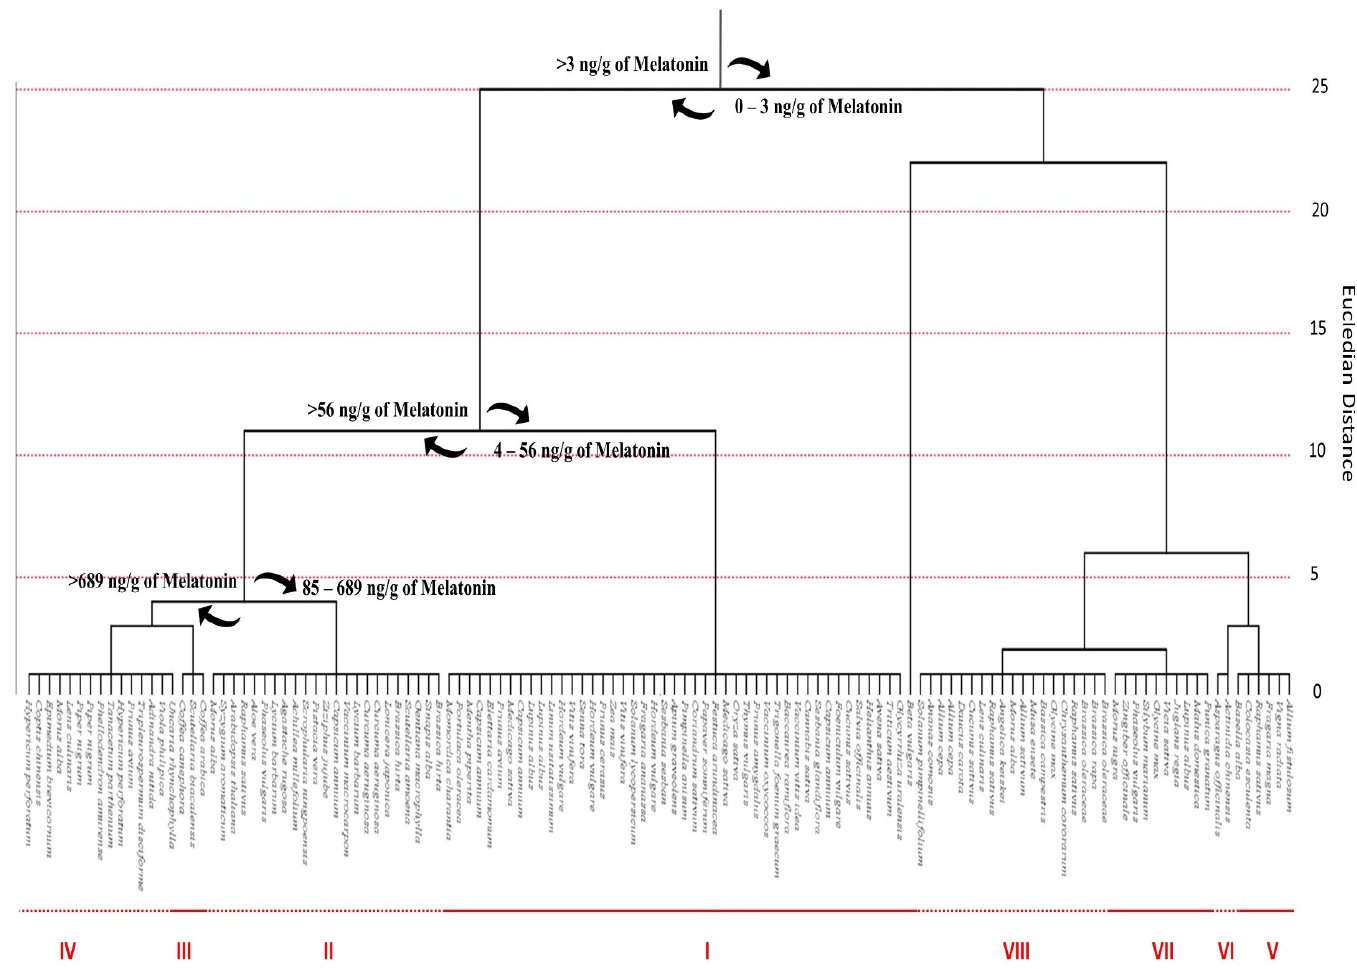
Figure 10. Cluster distribution of melatonin within plant species, according to previously published data [38,115,129–173]. Data are expressed as ng melatonin per g of FW Euclidean distances, calculated with centroid method. Statistical analysis and graphical representation were made using SPSS v. 24 software.